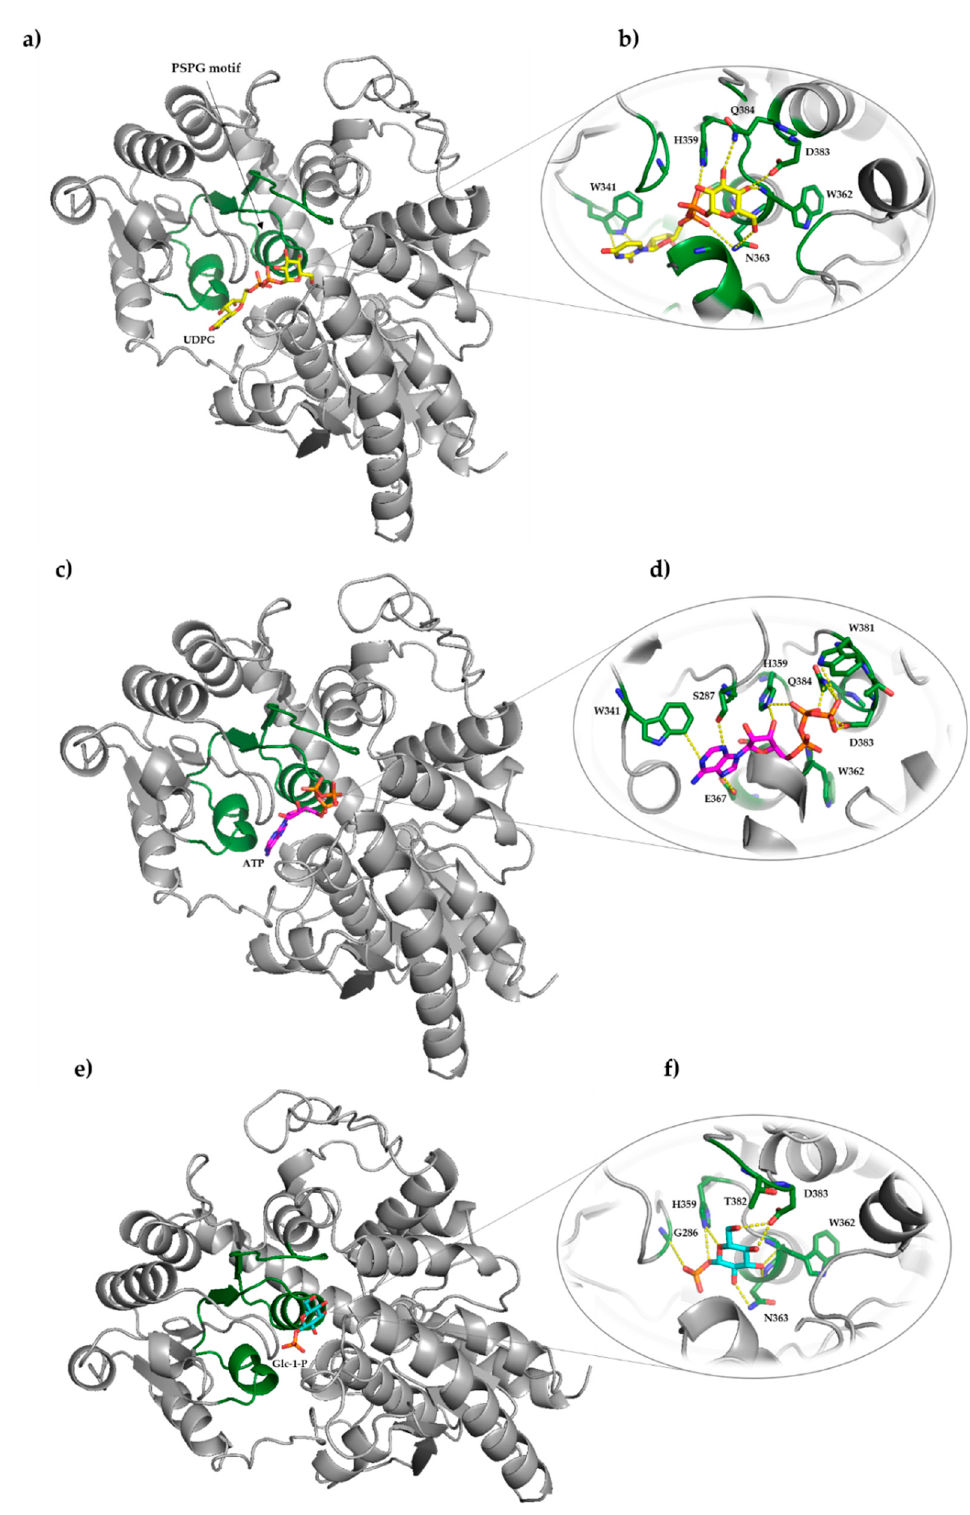
Figure 13. Docking analysis visualization of UDPG ( a ), ATP ( c ) and Glc-1-P ( e ) to IAGlc synthase performed with AutoDock. Hydrogen bonding interactions of UDPG ( b ), ATP ( d ) and Glc-1-P ( f ) with amino acid residues of the enzyme. Possible hydrogen bonds are marked with yellow dashed lines. The PSPG motif is presented in the ribbon-style representation in green.